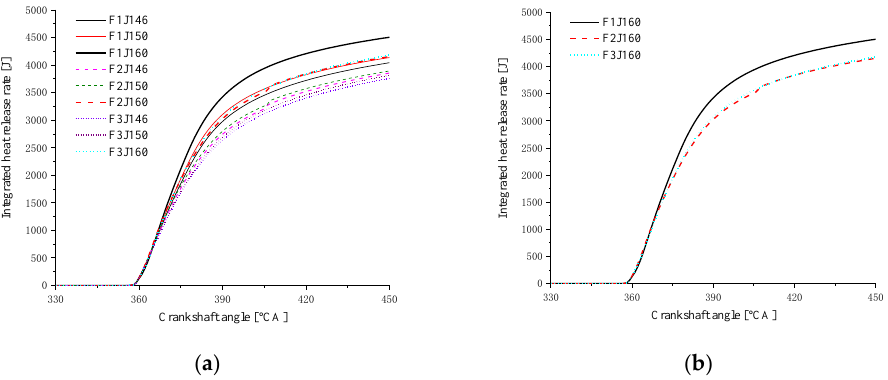
Figure 15. The integrated heat release of the three combustion chambers combined with three spray angles. ( a ) Three chambers combined with spray angles of 160°, 150° and 145°; ( b ) Three chambers combined with a spray angle of 160°.